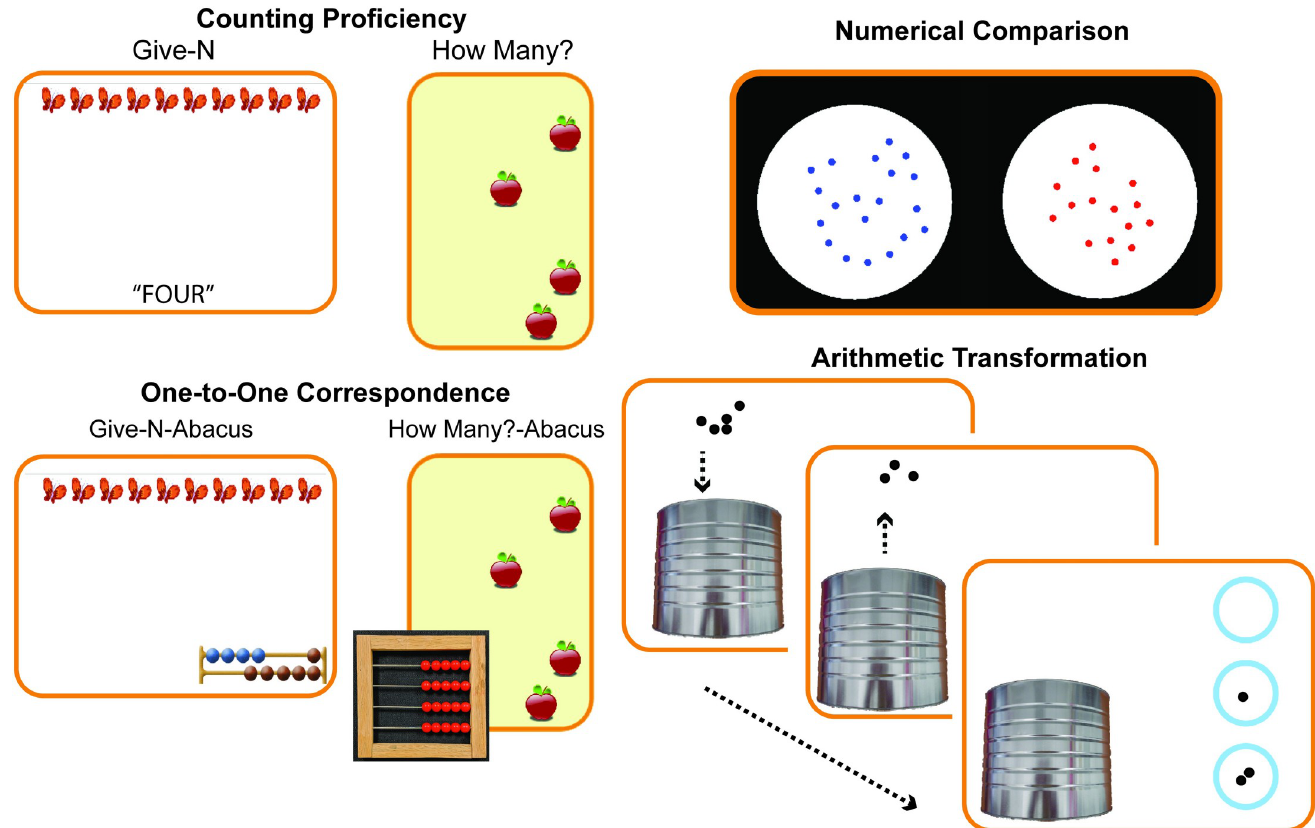
Fig 2. Depictions of numeracy assessment tasks. Counting proficiency was assessed using electronic versions of two well-known tasks designed to measure children’s ability precisely produce (Give-N) or enumerate (How Many?) sets of 1–8 items. On a single trial of the Give-N production task, children were asked to bring down a certain number of items (1–8) from a larger collection of 10 items at the top of the screen by pressing the SPACE bar. For the How Many? enumeration task, children were asked to report how many (1–8) items were presented on the screen. Numerical comparison was assessed by showing children a display containing two sets of dots side-by-side and asking them to point to the set with more dots. One-to-one correspondence was assessed by modified non-symbolic and non-verbal versions of our Give-N production and How Many? enumeration tasks, where verbal numbers were replaced by a non-verbal abacus. In the Give-N Abacus task, a visual representation of an abacus with a certain number of highlighted beads was presented at the bottom of the screen as the numerical prompt instead of a number word. Children were asked to match the same number of items as were on the abacus by bringing them to the bottom of the screen through pressing the SPACE bar. For the How many? Abacus task, children were presented with pictures containing 1 to 8 items on the computer screen and were asked to match the number of items on the computer screen by moving over the same number of beads on a physical abacus they were given. Arithmetic transformation was assessed using a non-symbolic subtraction task where 1–6 items entered a can via animation (e.g., 5), some or all of those items came out (e.g., 3), and then children were asked to choose how many items they thought were left in the can by pointing to the options of “zero”, “one”, or “two” items on the right part of the screen. Additional parameters of all tasks can be found in the main text. PLEASE NOTE: Figs are not to visual scale with actual assessment